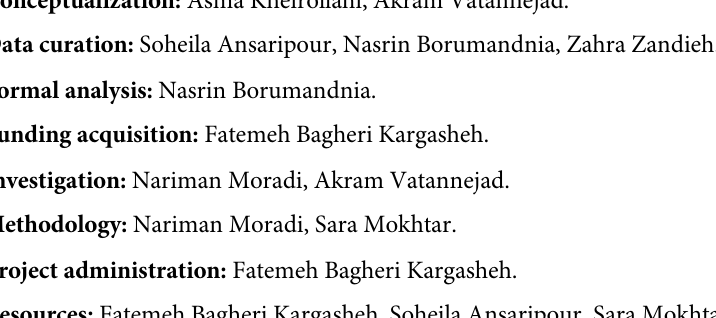
S1 Table. Association of the clinical characteristics and level of leptin and leptin receptor with genotypic frequencies for leptin (rs7799039) and leptin receptor (rs1137101) poly- morphisms in all